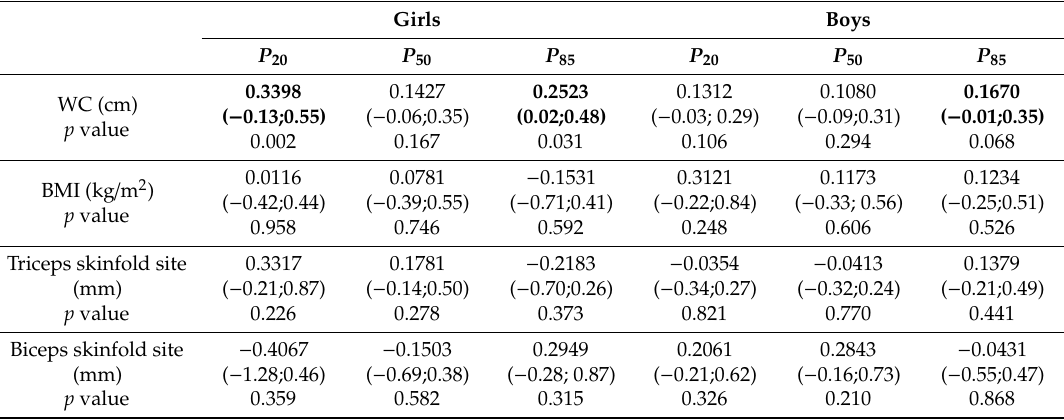
Table 4. Linear quantile regression for the association of diastolic blood pressure with anthropometric indices of